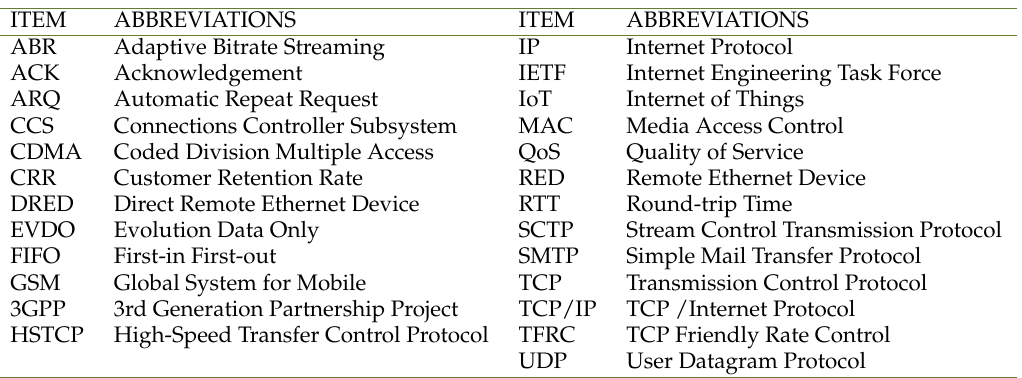
Table 3. Overall abbreviations of the scientific